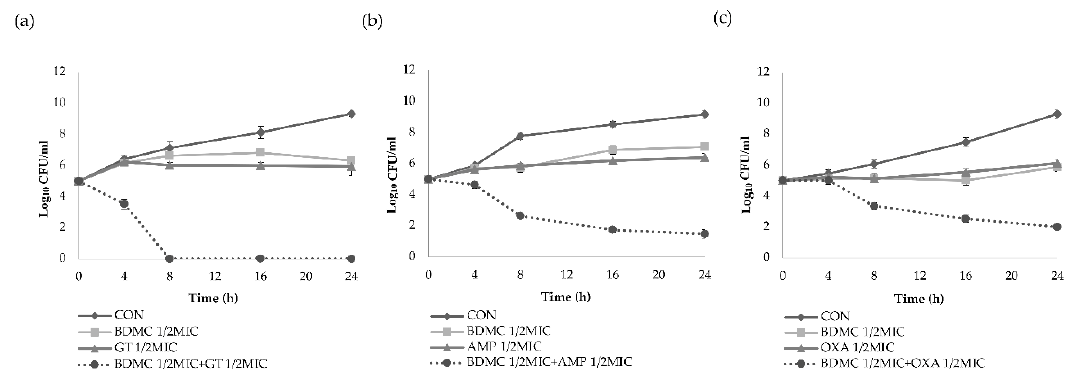
Figure 1. Bacterial viability at sub-minimum inhibitory concentrations of BDMC and antibiotics. ( a )